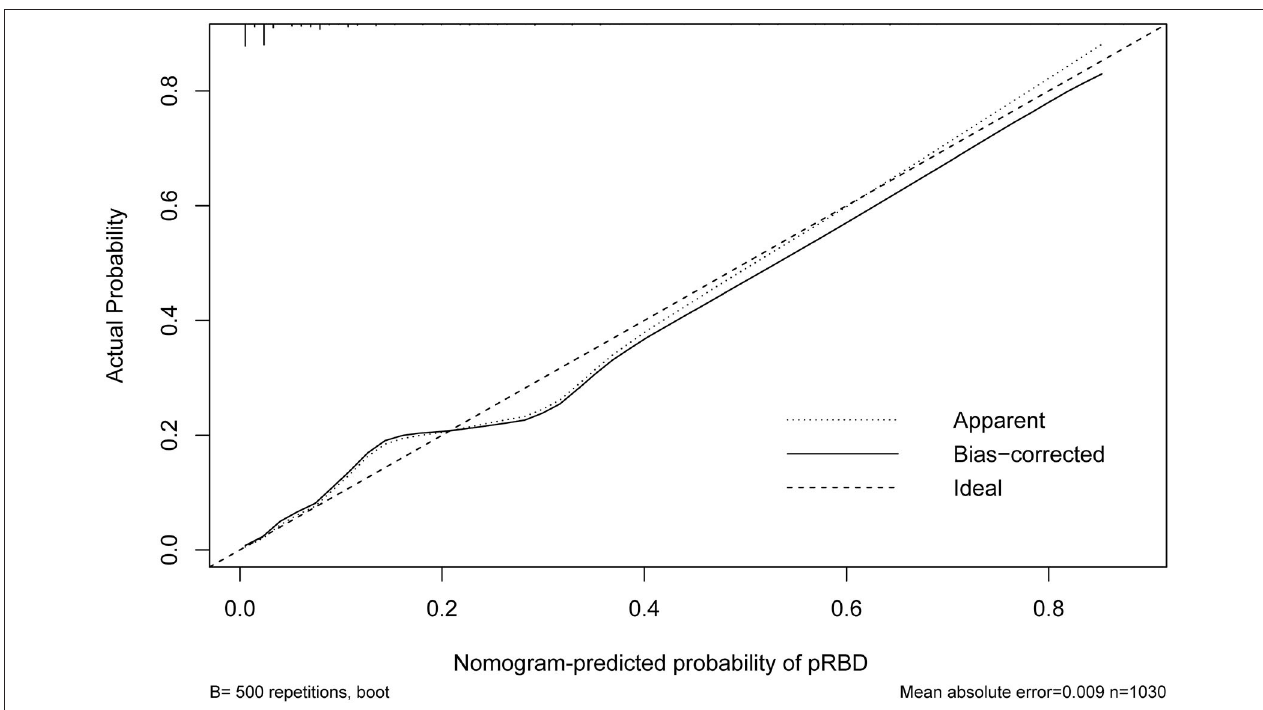
FIGURE 4 | Calibration curve of the nomogram. The X-axis represented the predicted possible rapid eye movement sleep behavior disorder (pRBD) risk. The Y-axis represented the actual diagnosed pRBD. The diagonal dotted line meant a perfect prediction by an ideal model. The short-dashed line represented the apparent prediction of nomogram, and the solid line was bias-corrected by bootstrapping (B = 500 repetitions), indicating observed nomogram